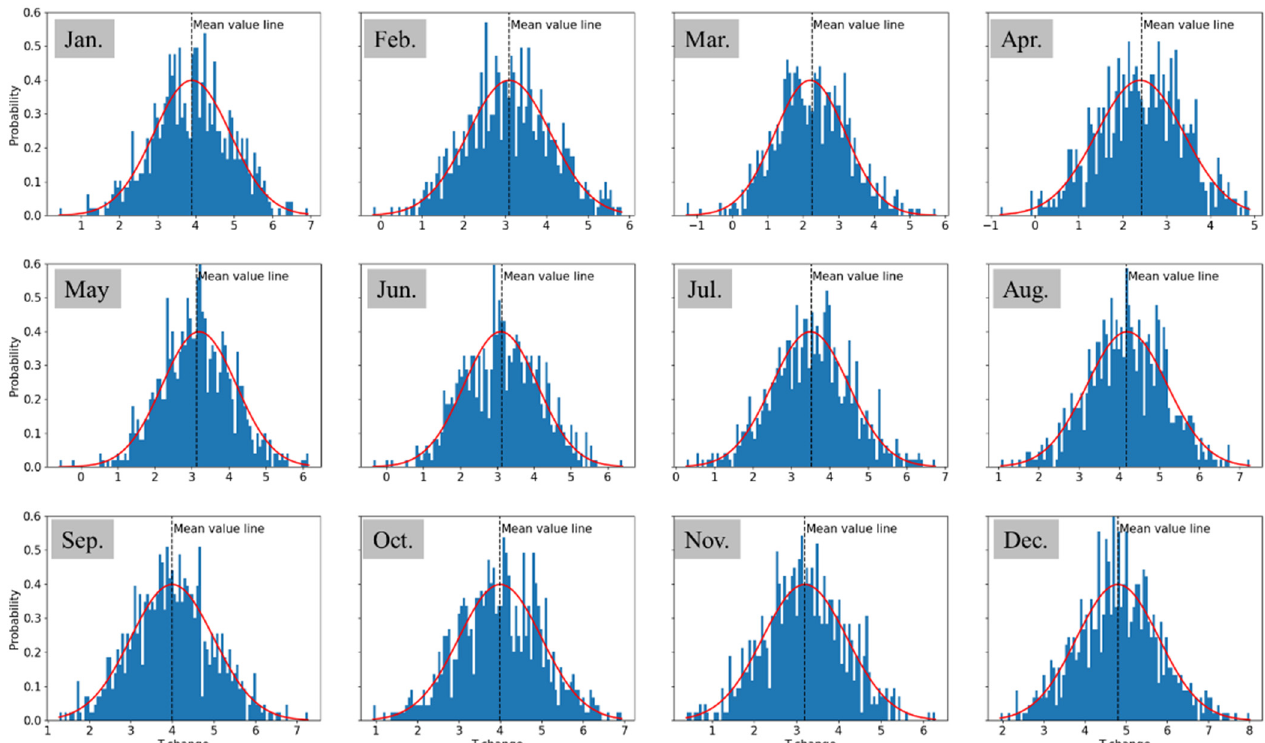
Figure 2. Monthly distributions of hourly temperature changes for scenario the 2050s in 4A New York, NY.